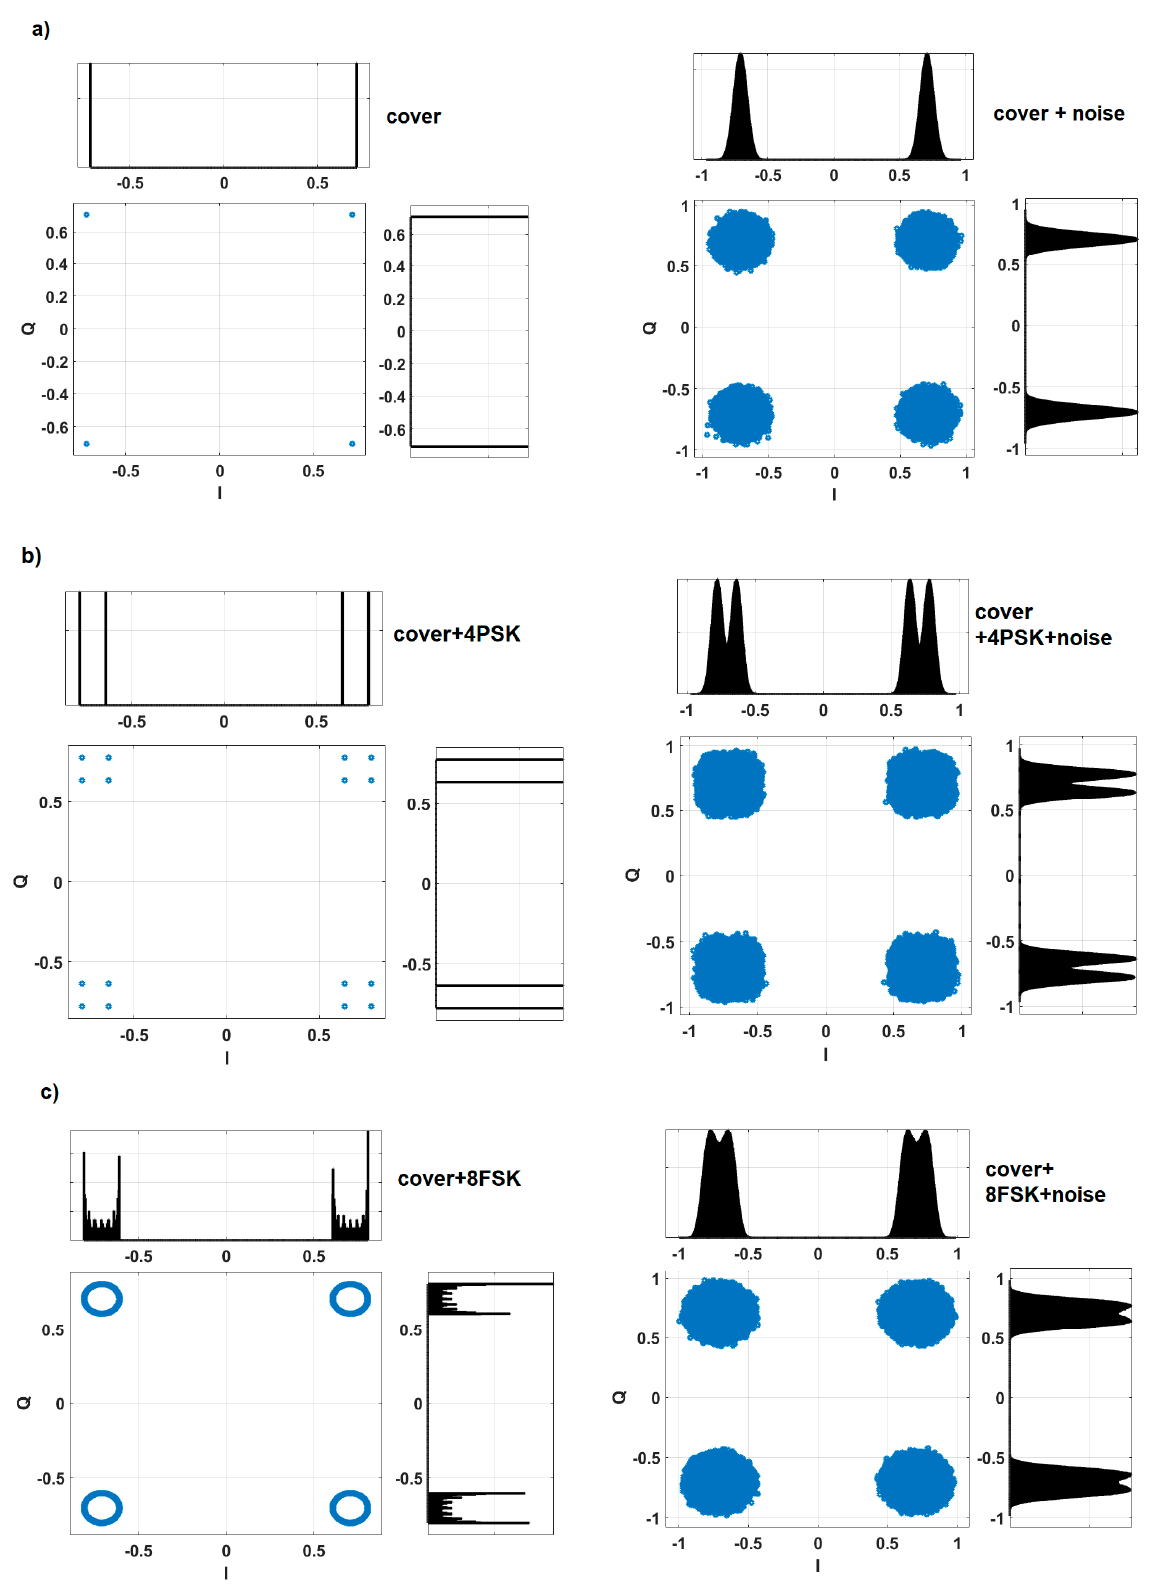
Figure 7. Constellations and histograms for ( a ) cover (QAM); ( b ) cover + 4PSK; ( c ) cover + 8FSK for noiseless and gaussian noise.